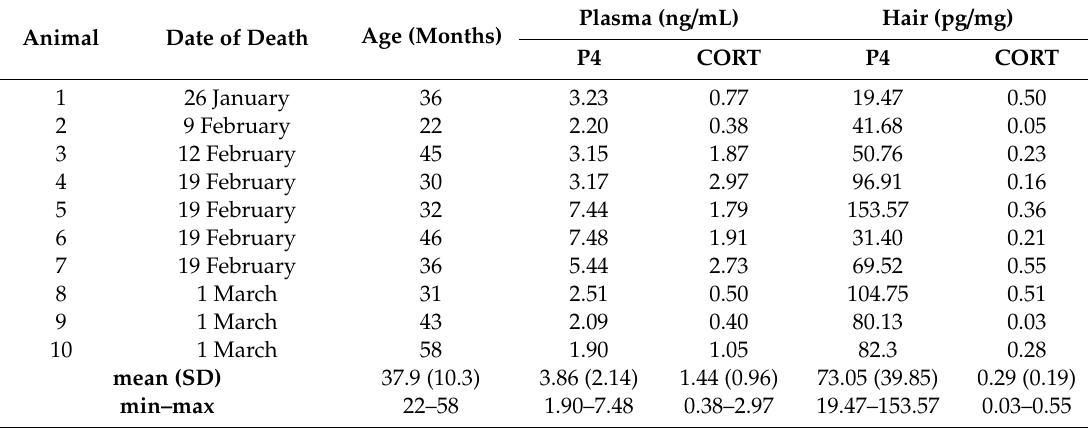
Table 1. Descriptive data of the red deer hinds and quantified